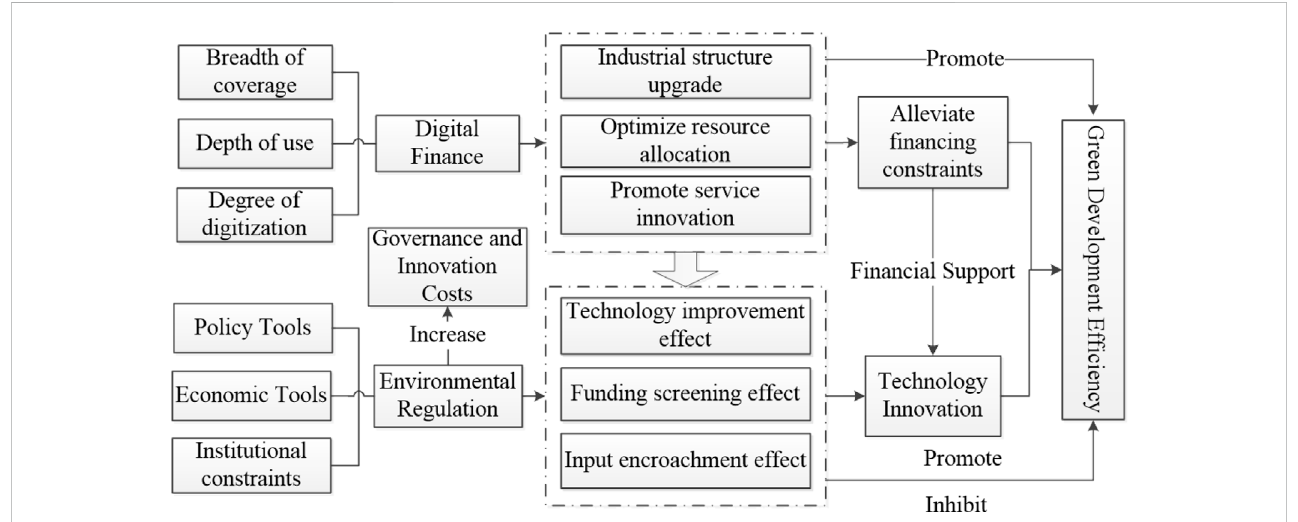
FIGURE 1 In fl uence mechanism of digital fi nance, environmental regulation and green development ef fi